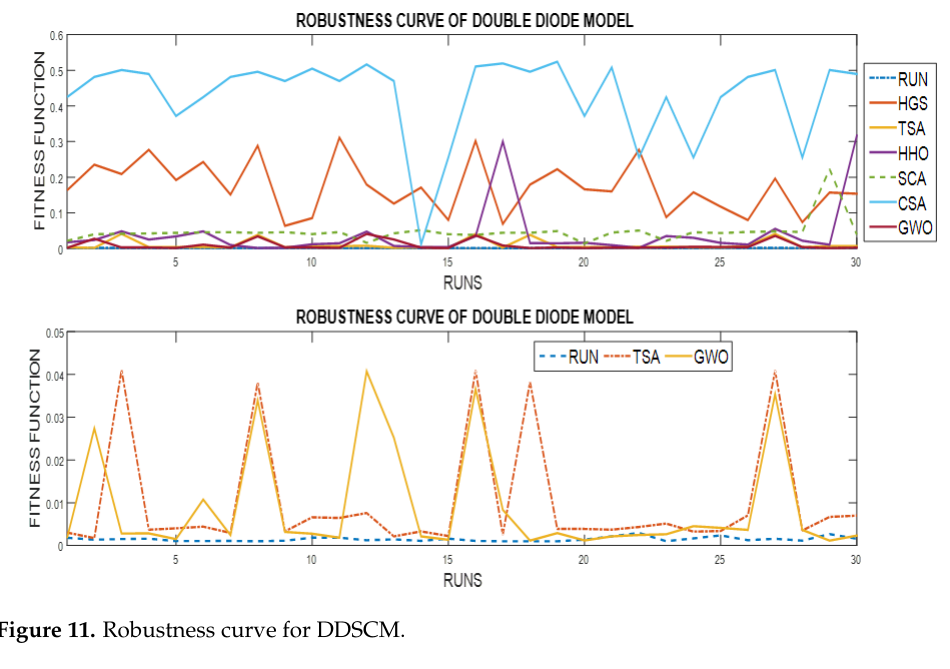
Figure 11. Robustness curve for DDSCM.